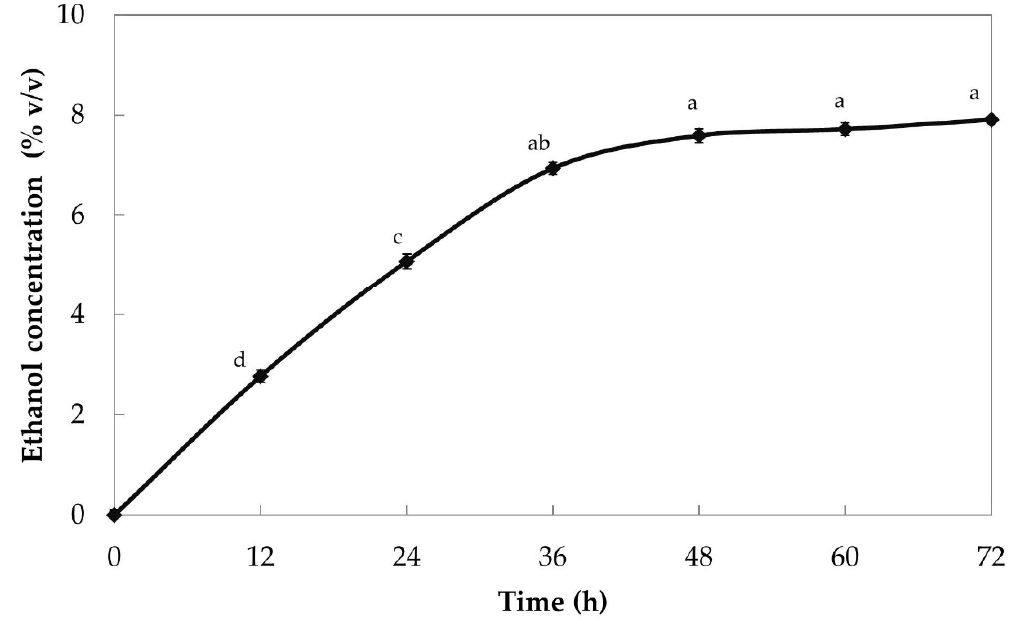
Figure 5. The yield of ethanol production by K. marxianus SS106 at 40 °C in 5 ‐ L fermenter using single ‐ step ethanol fermentation. (Comparison of those values among fermentation times at p ‐ value 0.05 shows different characters, a, b and c, which are statically significant difference.).